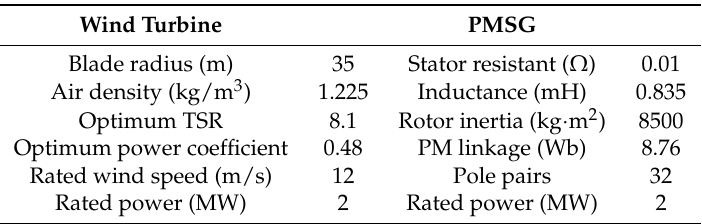
Table 1. Parameters of the